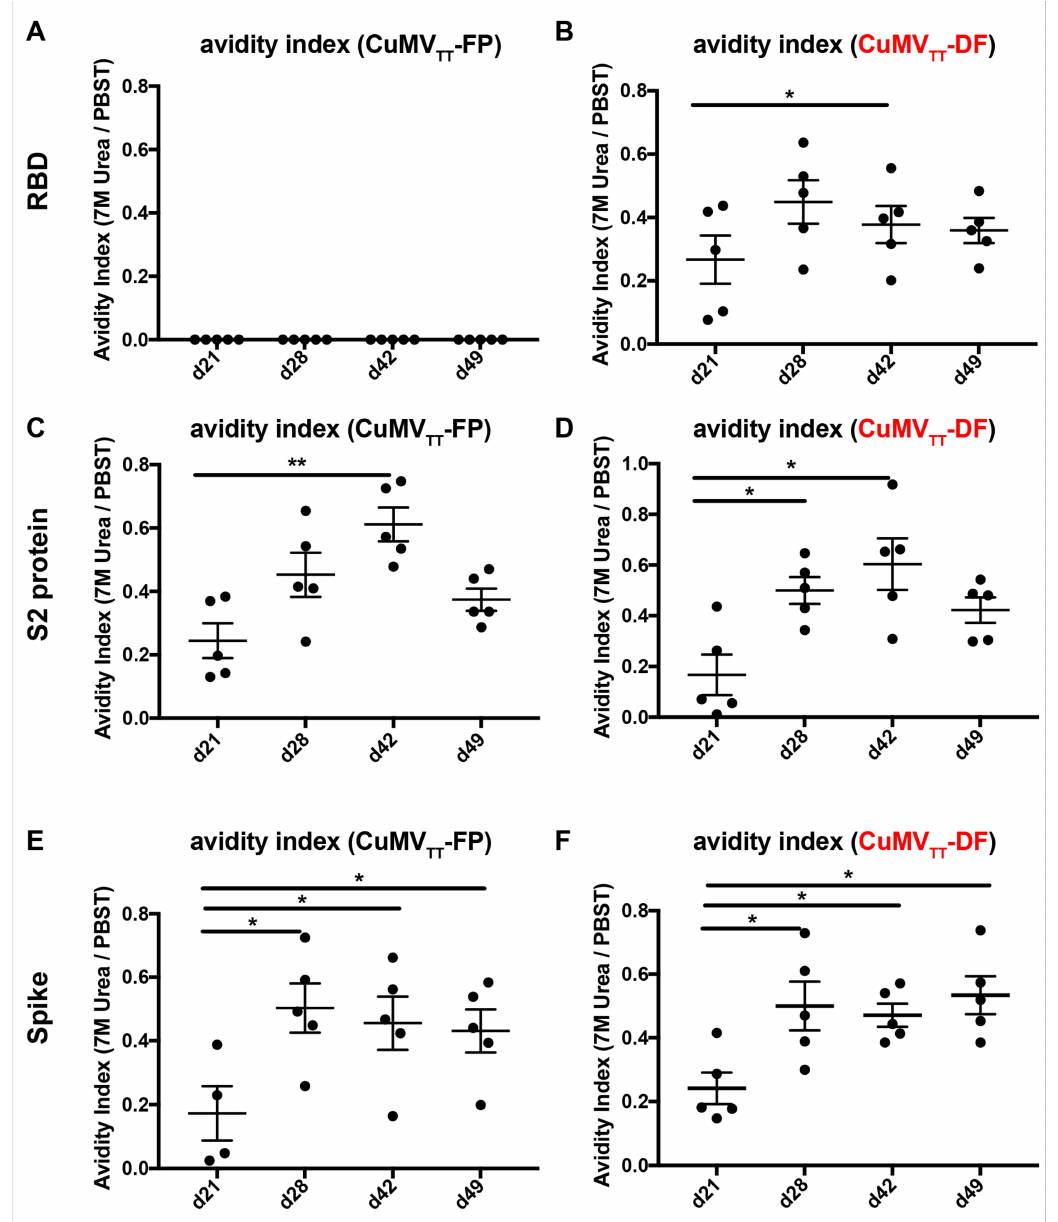
Figure 3. Avidity indexes of IgG antibodies in mice before and after booster immunization of CuMV TT -FP and CuMV TT -DF (right panel, indicated as red) measured by avidity ELISA ( n = 5). ( A , B ): Avidity indexes of IgG antibodies for RBD from CuMV TT -FP ( A ) or CuMV TT -DF ( B ) immunized mice; ( C , D ): Avidity indexes for spike S2 protein of CuMV TT -FP ( C ) or CuMV TT -DF ( D ) elicited IgG antibodies; ( E , F ): Avidity indexes for spike S2 protein of CuMV TT -FP ( E ) or CuMV TT -DF ( F ) stimulated IgG antibodies. Paired t-test in GraphPad Prism 7 was used for statistical analysis. α = 0.05 and statistical significance were displayed as p ≤ 0.05 (*), p ≤ 0.01